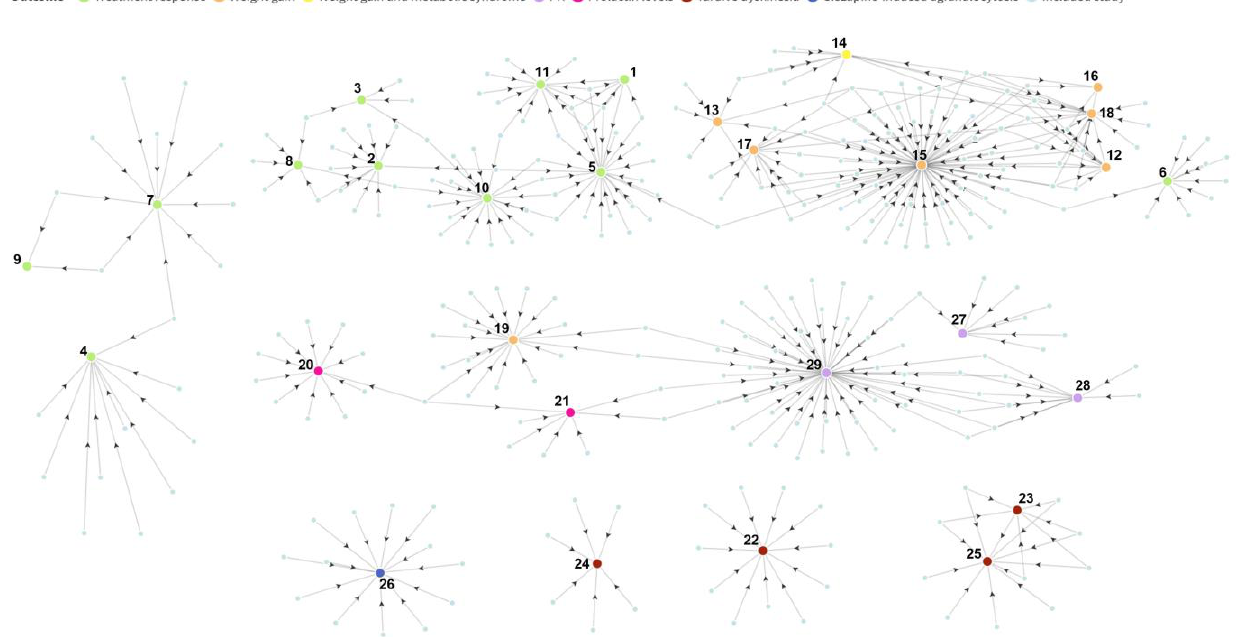
Figure 2. Network of the coverage of included meta-analyses. Footnote: Bigger dots represent meta- analyses included in this study; smaller dots represent original research studies included in each meta-analysis. Assorted colors indicate different outcomes. References: Study 1, Hwang, 2010 [34]; 2, Zhang, 2010 [46]; 3 de Matos, 2015 [47]; 4, Huang, 2016 [43]; 5, Gressier, 2016 [31]; 6,